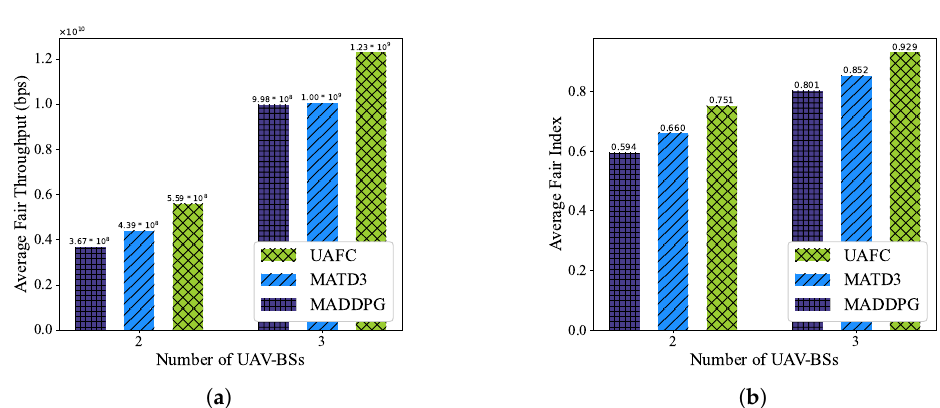
Figure 9. The impact of the number of UAV-BSs on system performance. ( a ) Average fair throughput. ( b ) Average fair